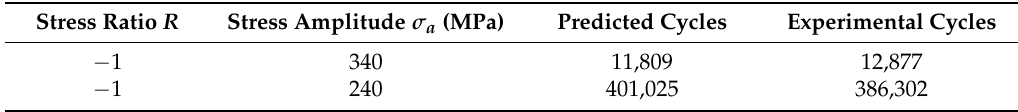
Table 5. Predicted results under different stress